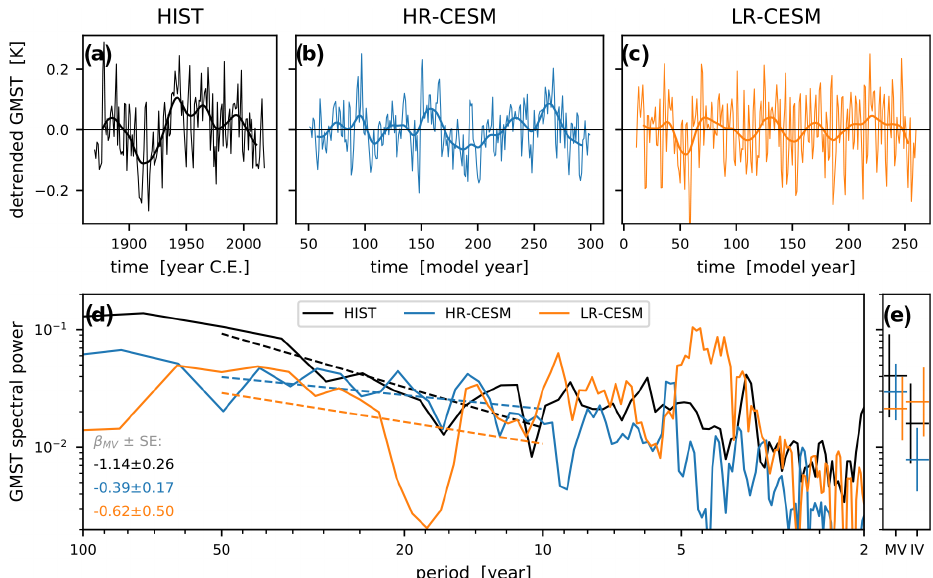
Figure 8. Time series of the detrended annual global mean surface temperature ( a–c ; thin lines) and the 13-year low-pass-filtered time series (thick lines). Multi-taper spectral estimates from the time series ( d ; solid lines) with the fitted spectral slopes β MV between 50 and 10 years (dashed). The slope estimates and their standard error are written in the lower left corner of panel (c) . Panel (e) shows the mean spectral power in the multidecadal (10–50 years) and interannual (2–10 years) bands with the standard deviation estimates as error